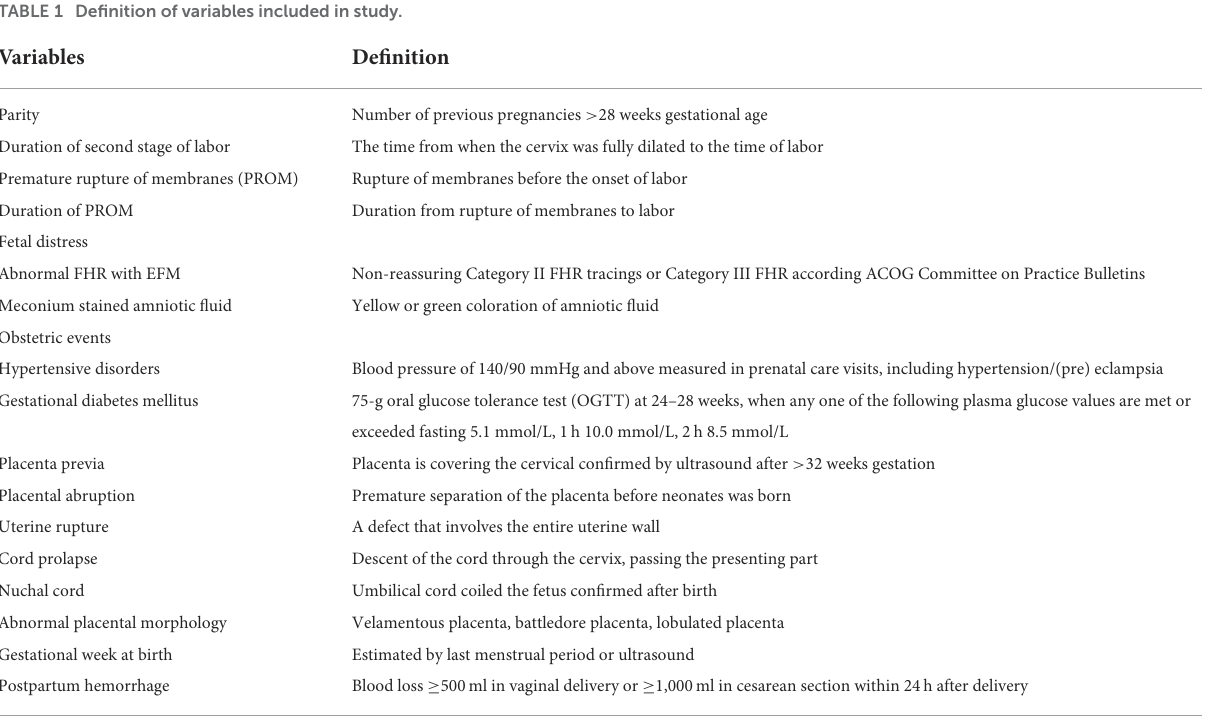
TABLE 1 Definition of variables included in